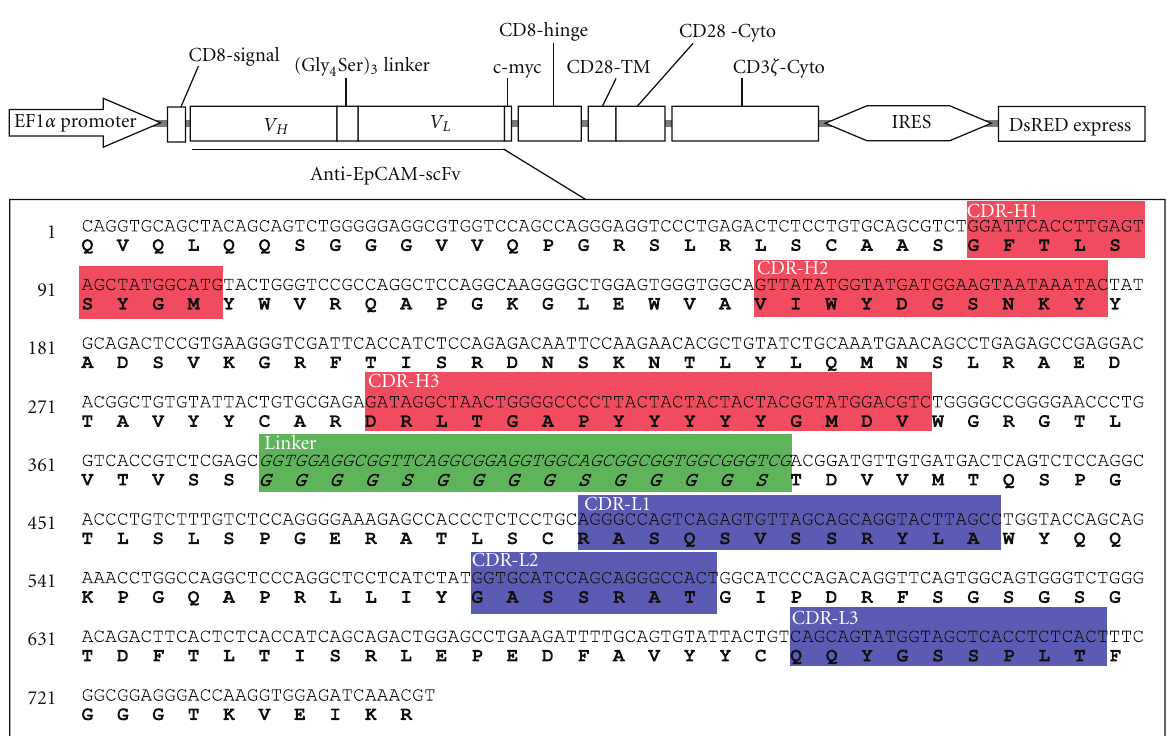
Figure 2: Schematic representations of CAR57-28 ζ . The nucoleotide and aminoacid sequences of anti-EpCAM scFv from the M13-57 hybridoma were analyzed using the IMGT/V-QUEST and IMGT/JunctionAnalysis online tools (http://www.imgt.org/), and each comple- mentarity-determining region (CDR) of the cloned scFv gene was determined according to Chothia’s definition [10]. V H , variable region of the heavy chain; V L , variable region of the light chain; TM, transmembrane domain; Cyto, cytoplasmic domain.